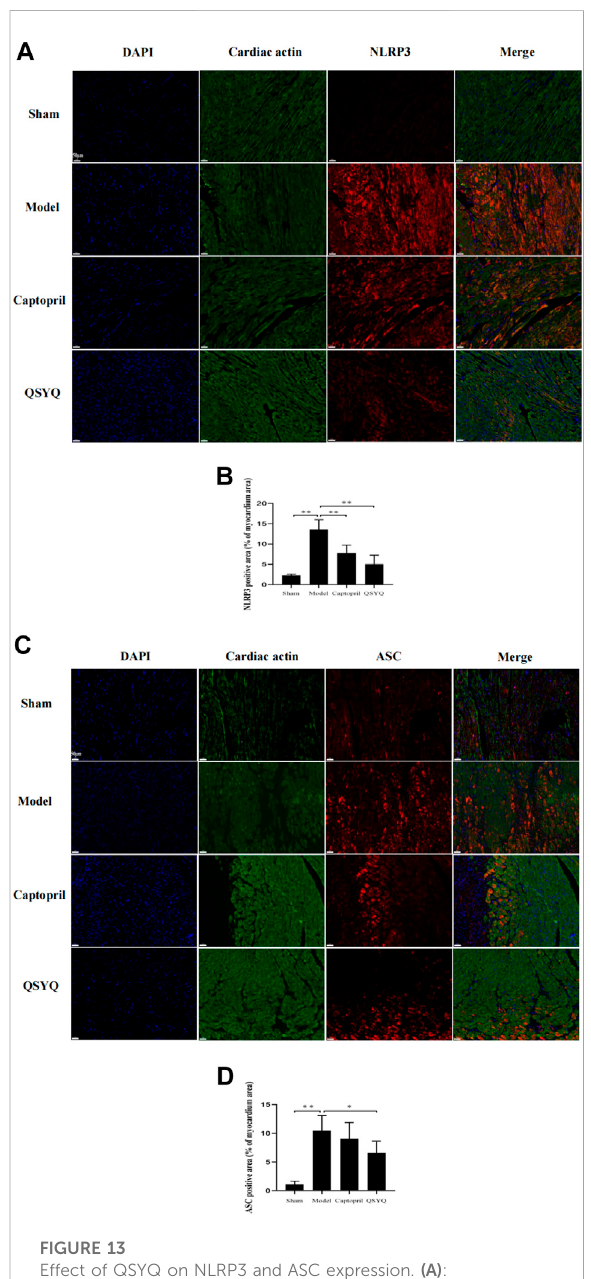
FIGURE 13 Effect of QSYQ on NLRP3 and ASC expression. (A) : Immuno fl uorescence staining showed: the expression of NLRP3 was upregulated in model group. After treatment with captopril or QSYQ, the NLRP3 expression signi fi cantly decreased in both of the treatment groups (Magni fi cation, × 200). (B) : Quantitative analysis of NLRP3 expression in myocardium, n = 4 per group. Data are expressed as mean ± SD. ** p < 0.01. (C) : Immuno fl uorescence staining showed: the expression of ASC was up-regulated in model group. The ASC expression decreased in QSYQ group, however, there was no signi fi cant change in captopril group(Magni fi cation,×200). (D) :Quantitativeanalysis of ASC expression in myocardium, n = 4 per group. Data are expressed as mean ± SD. *p < 0.05, **p <